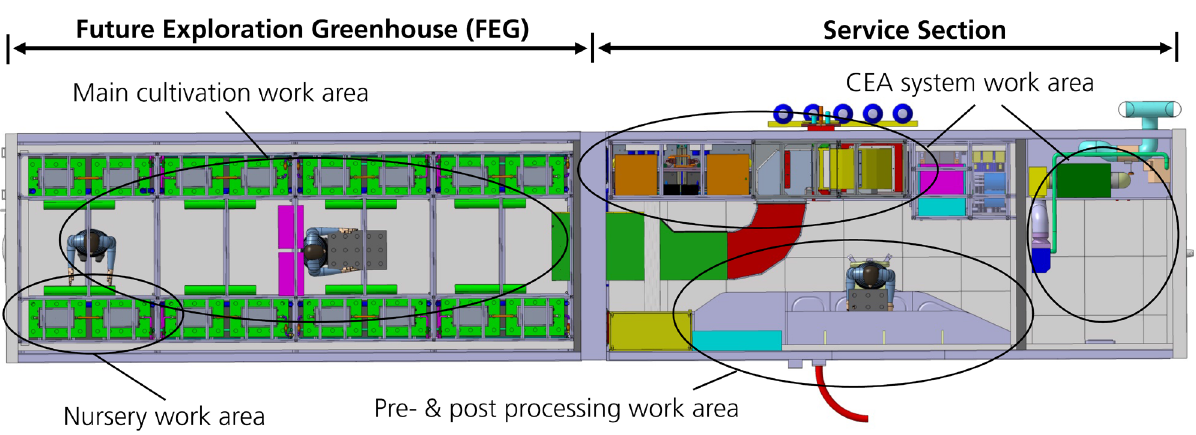
Figure 6: Work locations within the MTF (top-view) of the EDEN ISS project. The main cultivation area (FEG), the nursery area (FEG) for Ge- and NU-cultivation phases, the pre- and post-processing area, and the CEA system work area are indicated by the black